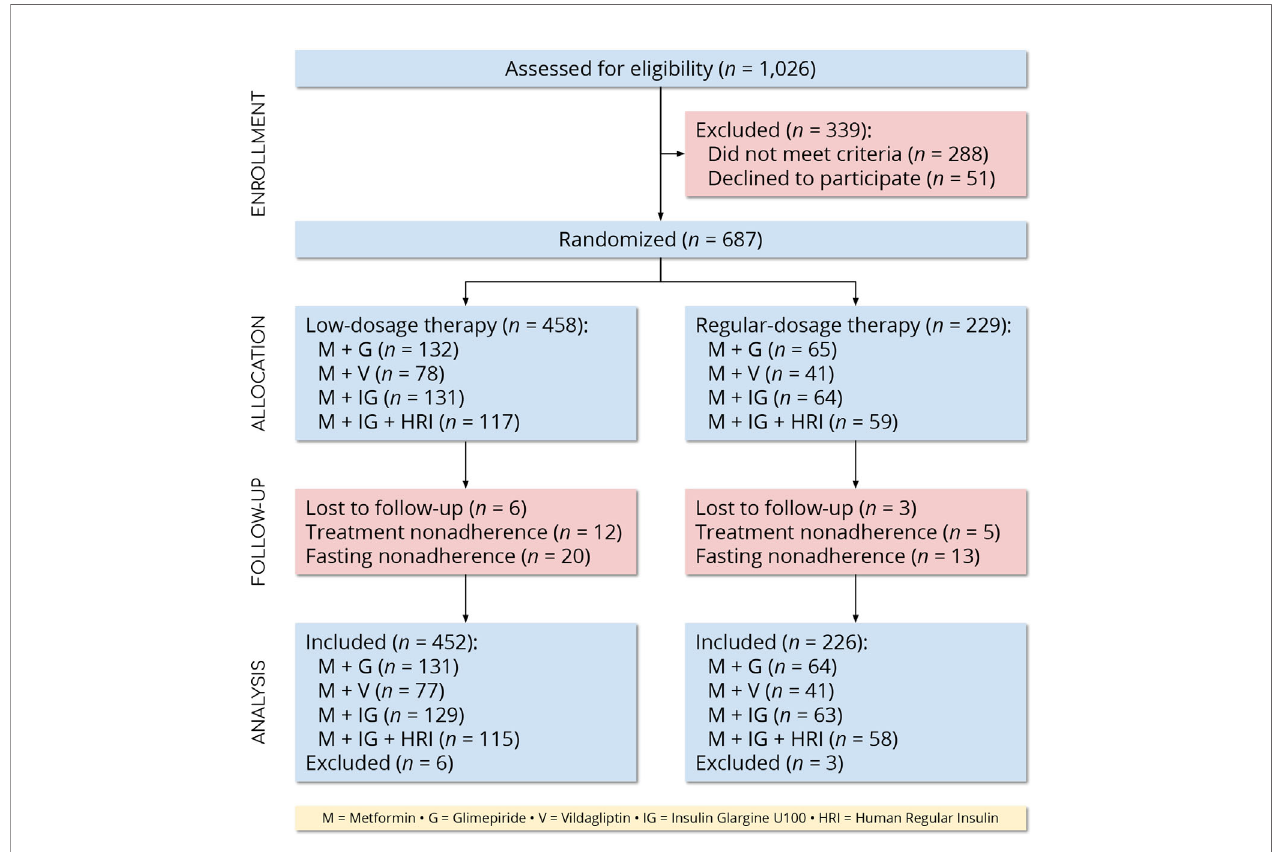
FIGURE 1 | CONSORT fl ow diagram. ( N = 678